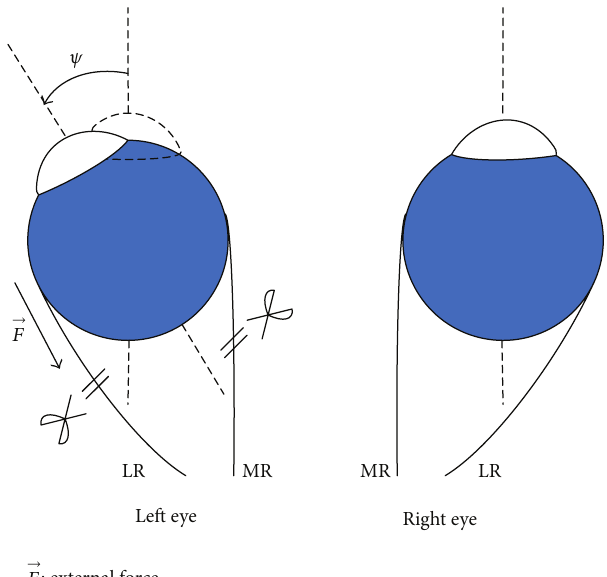
Figure 2: Schematic of double eyes only with the lateral rectus (LR) and the medial rectus (MR): not all the six EOMs are